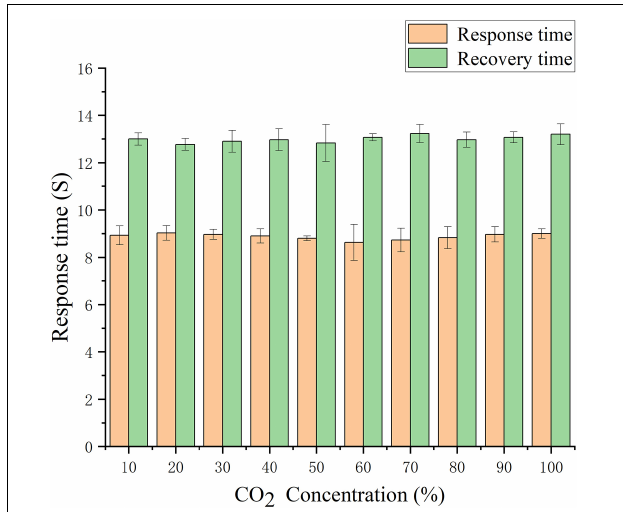
of non-MWCNTs modified, MWCNTs modified and MD62 which produced by Winsen (China) company (Winsen, 2018) with sensitivity of 0.0061 V/10% CO 2 were tested, as shown in Figure 12 . The sensitivity of the modified MWCNTs is much higher compared with the sensor before modification and